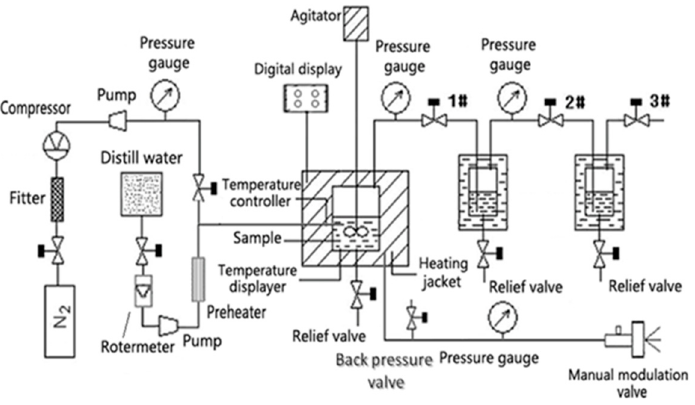
Figure 7. The schematic diagram of subcritical reaction system.